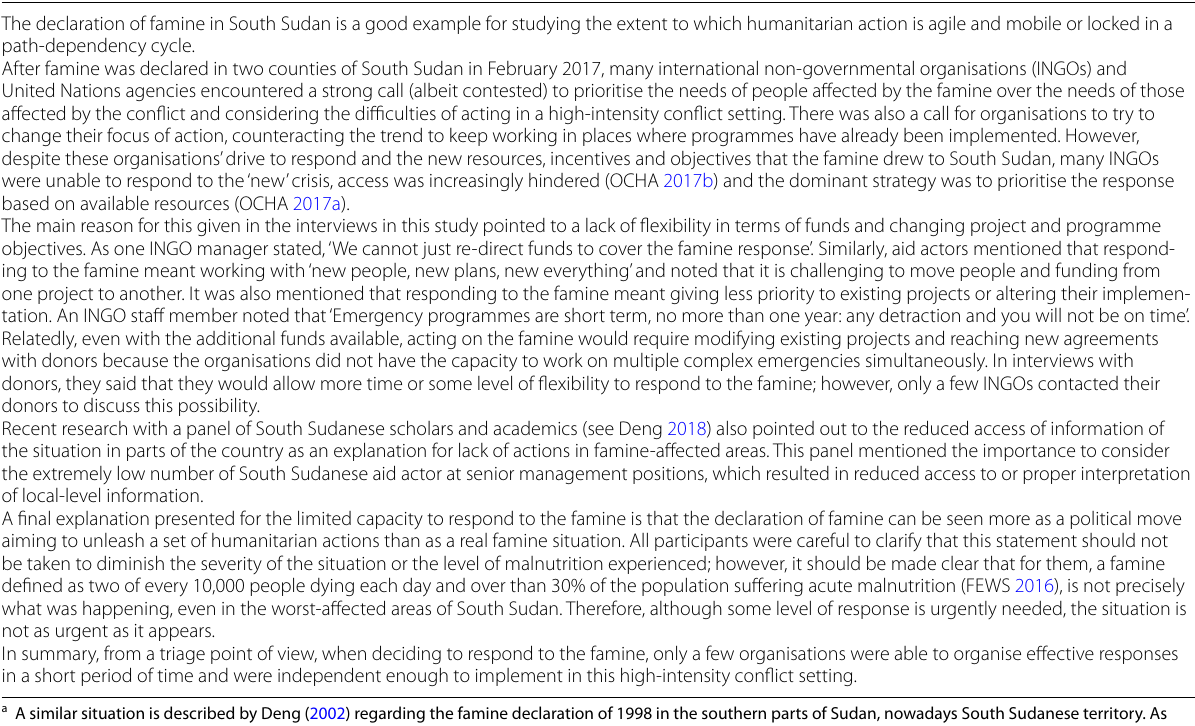
Table 2 The example of path dependency in the famine